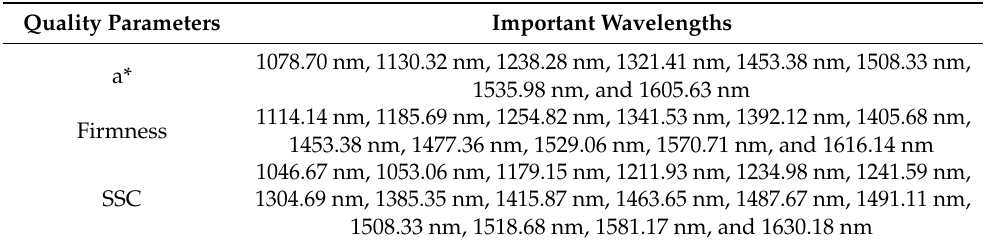
Figure 7. Number of retained wavelengths in each IRIV iteration. Table 4. Important wavelengths for different parameters.